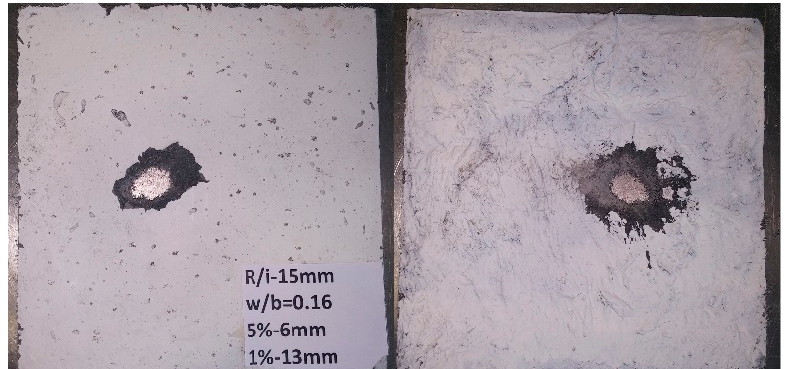
Figure 5. Failure type I—full penetration of the slab (front face at the left and rear face at the right ) . Reprinted/adapted by permission from Springer Nature: Springer Nature Switzerland AG, Mina, A.L.; Trezos, K.G.; Petrou, M.F. Mechanical Properties of Ultra High Performance Fibre Rei-